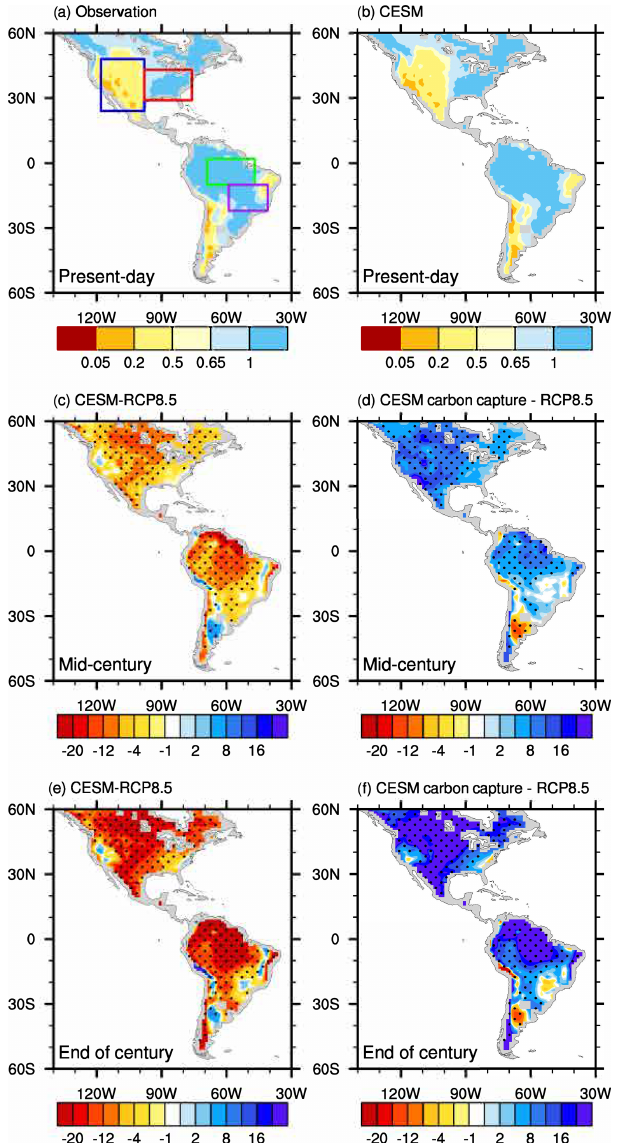
Figure 5. P / PET in the present day, the relative changes (%) in the future under RCP8.5, and mitigation due to carbon capture geoengi- neering using CESM. (a, b) The reanalysis and the bias-corrected output of the model in the present day (unitless). (c) The projected baseline changes relative to the present day (%); (d) the mitigation of the baseline changes relative to the present day. (e, f) Same as (c, d) but for the end of the century. The similar P / PET changes in absolute values (unitless) can be found in the top row of Fig.